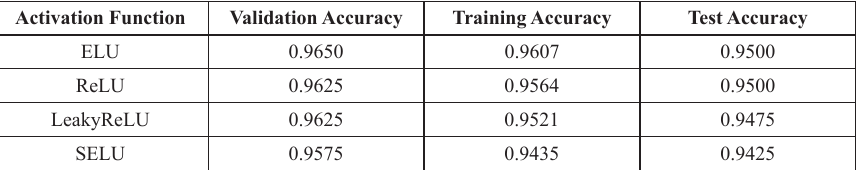
Table 5. Accuracy of different activation functions on validation, train, and test set